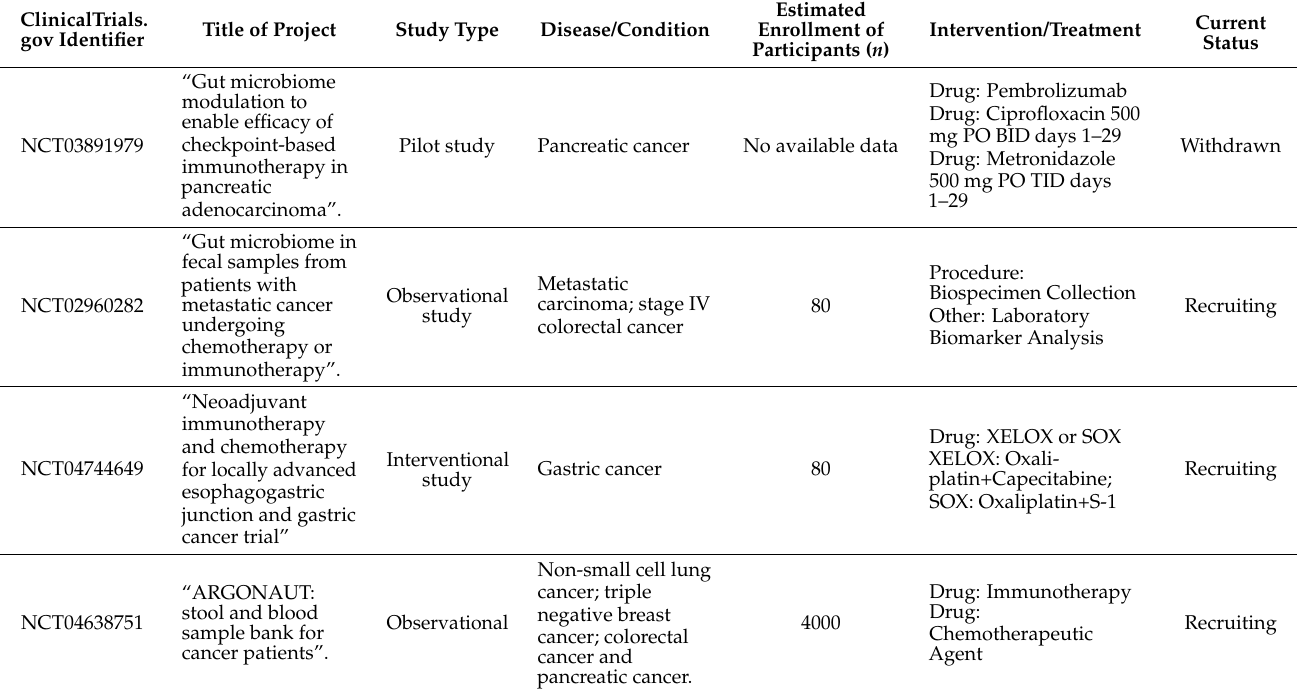
Table 2. The current project registered in ClinicalTrials.gov system regarding gut microbiome-related aspects and im- munotherapy in